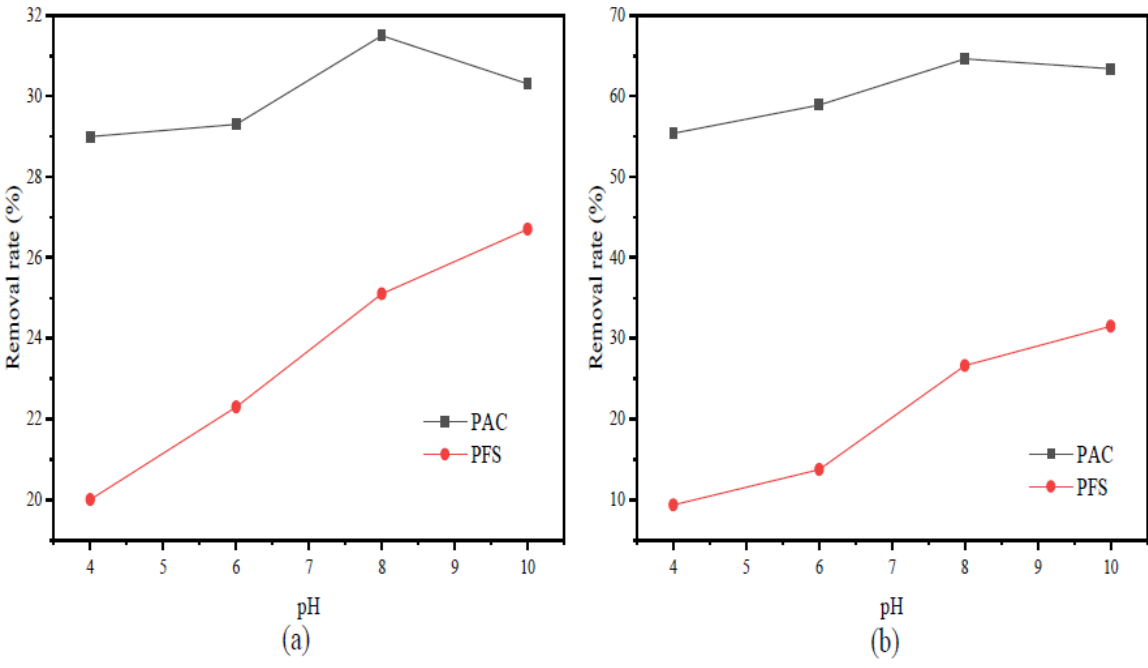
Figure 2. Effect of pH on the COD and chroma removal rate: ( a ) COD and ( b ) chroma.